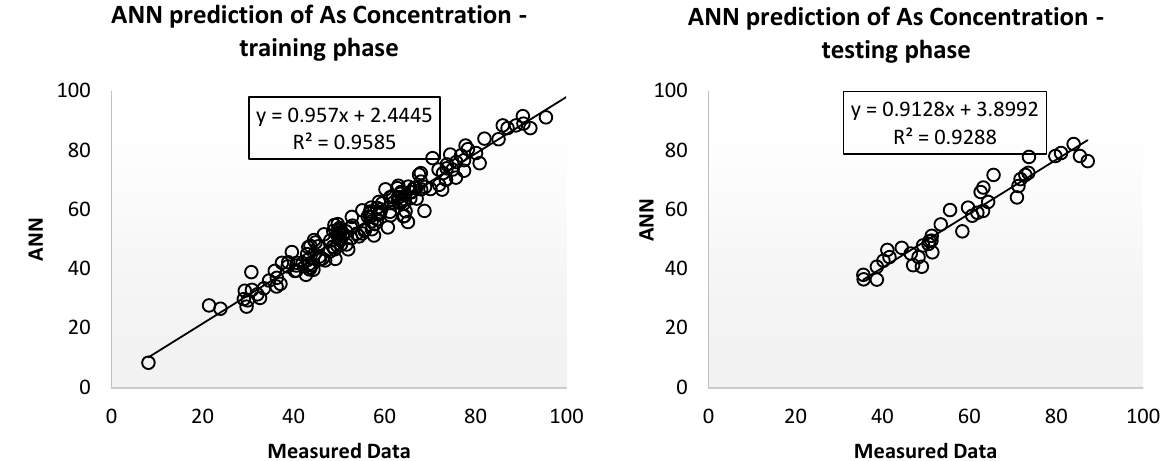
Figure 6. Scattered plot of predicted with actual values for As in training (left) and testing (right) phases ANN: Artificial neural network